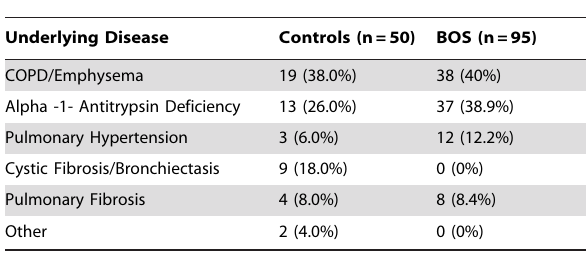
Table 1. Subject underlying diseaseunderlying Disease.